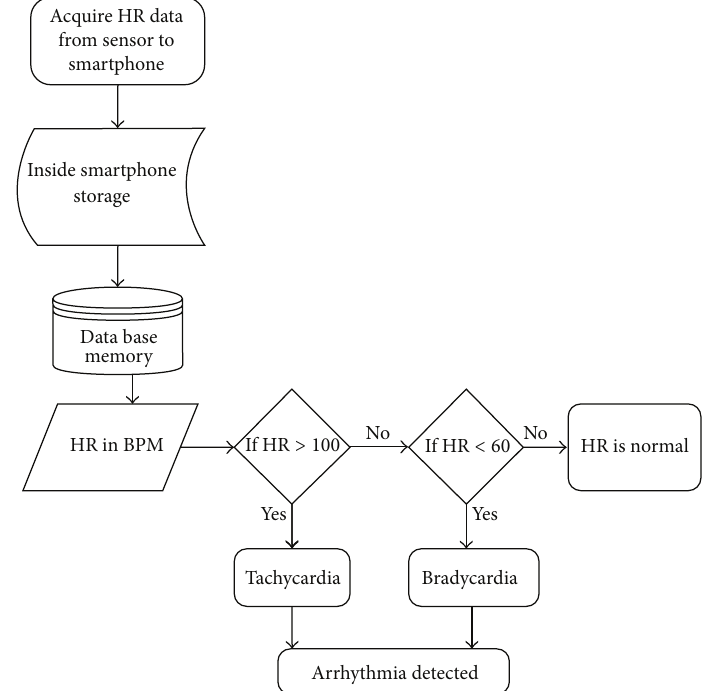
Figure 8: Flowchart of alarming mechanism.